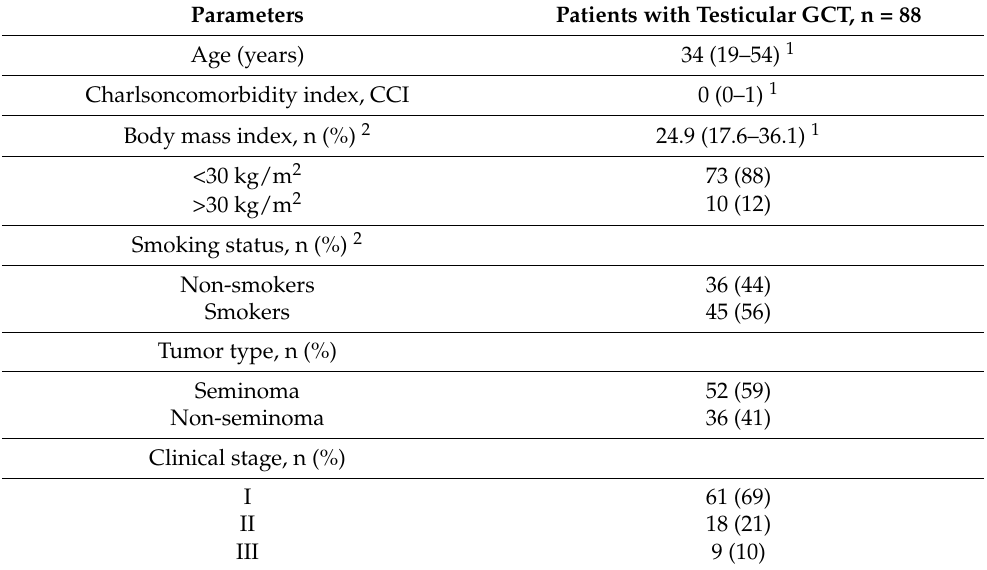
Table 1. The characteristics of patients with testicular